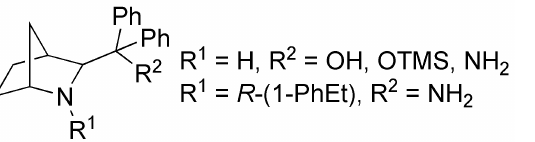
Figure 1. Structure of organocatalysts based on 2-azanorbornane prepared by Nakano’s group.